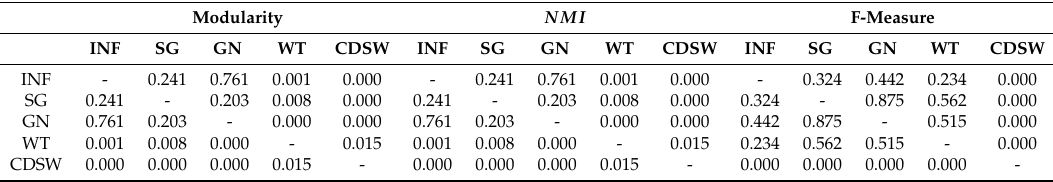
Table 5. p -value obtained from t -test for modularity, NMI and F-measure.